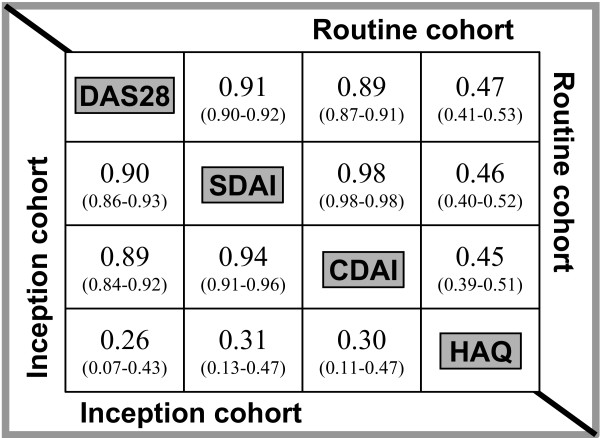
Cross-sectional correlation of composite scores and correlation with HAQ scores. Matrix displaying Spearman rank coefficients (95% confidence intervals) for cross-sectional correlations of Disease Activity Score (DAS)28, Simplified Disease Activity Index (SDAI), Clinical Disease Activity Index (CDAI), and Health Assessment Questionnaire (HAQ) in the routine cohort (upper diagonal half; n = 720 for correlations with HAQ, otherwise n = 767) and the inception cohort (lower diagonal half; n = 104 for correlation with HAQ, otherwise n = 105).